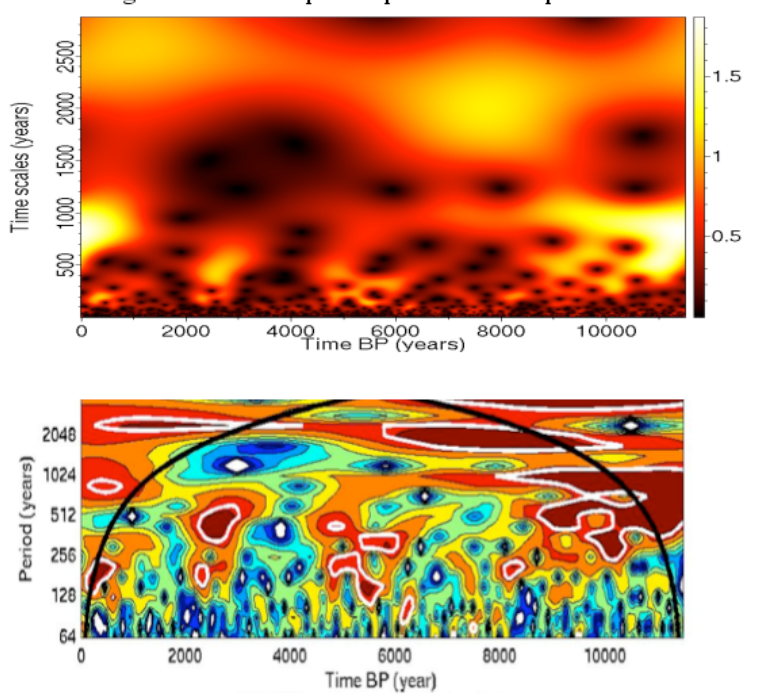
Fig. 3. Shows a scalogram and a wavelet power spectrum of the 14 C production rate from 9950 BC to 1950.